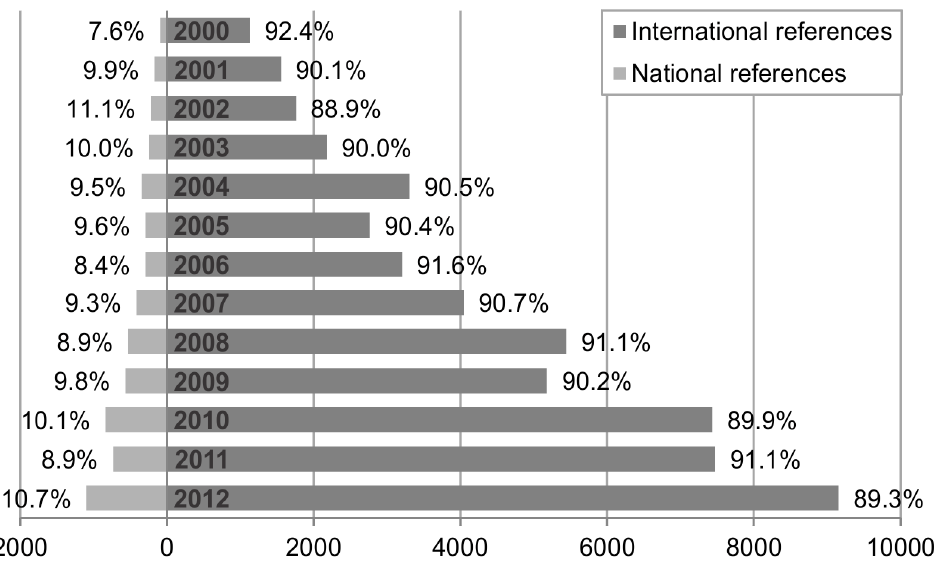
Figure 3. National versus international articles in Brazilian scientific output in Evolutionary Biology.